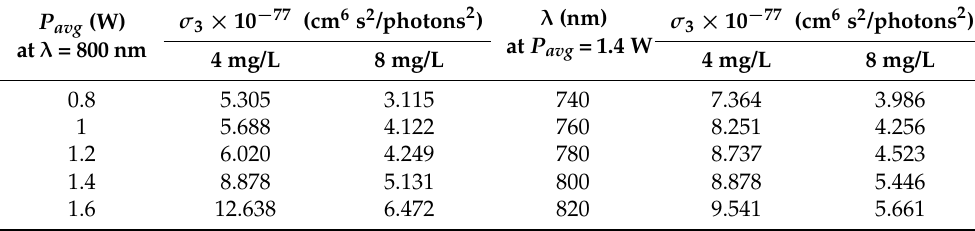
Table 1. The three-photon absorption cross-section for 4 mg/L and 8 mg/L Au NP concentrations. P avg